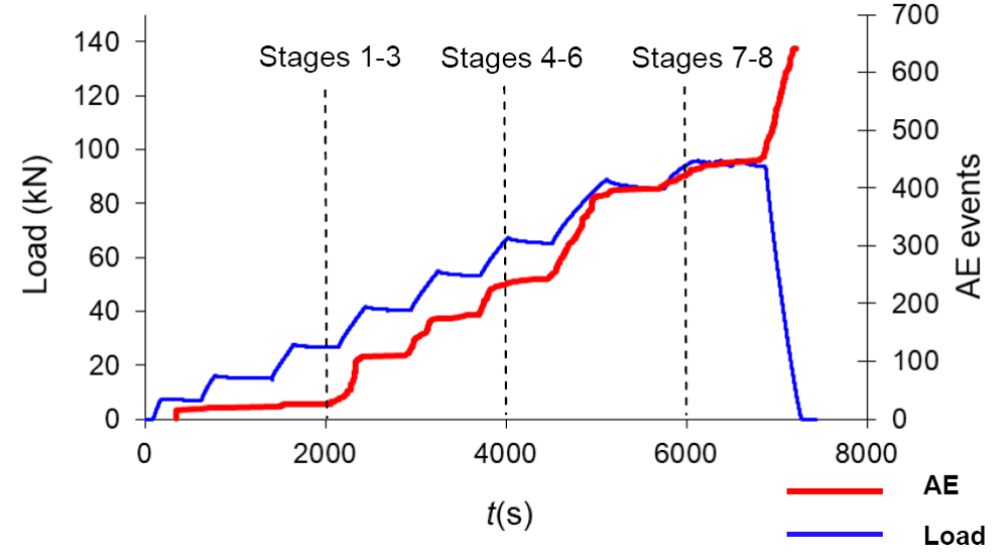
Figure 5. Step load (blue line) and cumulated AE signals time history (red line). Dashed lines correspond to the 3rd, 6th and 8th load stages.